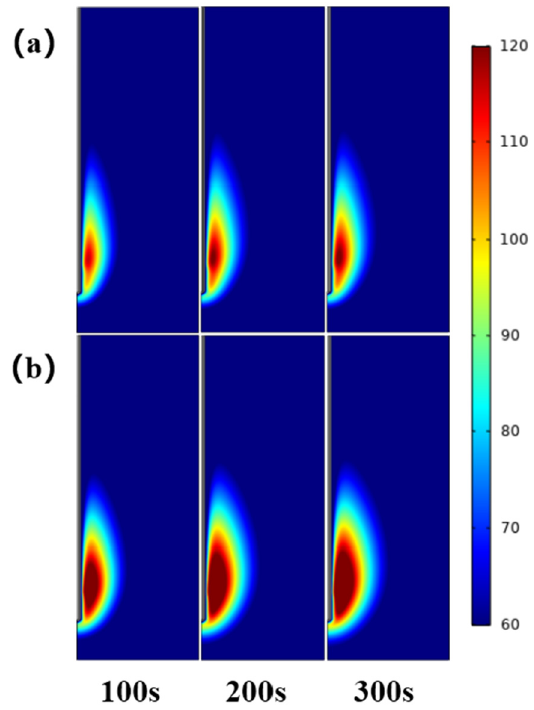
Figure 8. Thermal field distribution of microwave ablation Power = 40 W, ( a ) inflated group; ( b ) deflated group.